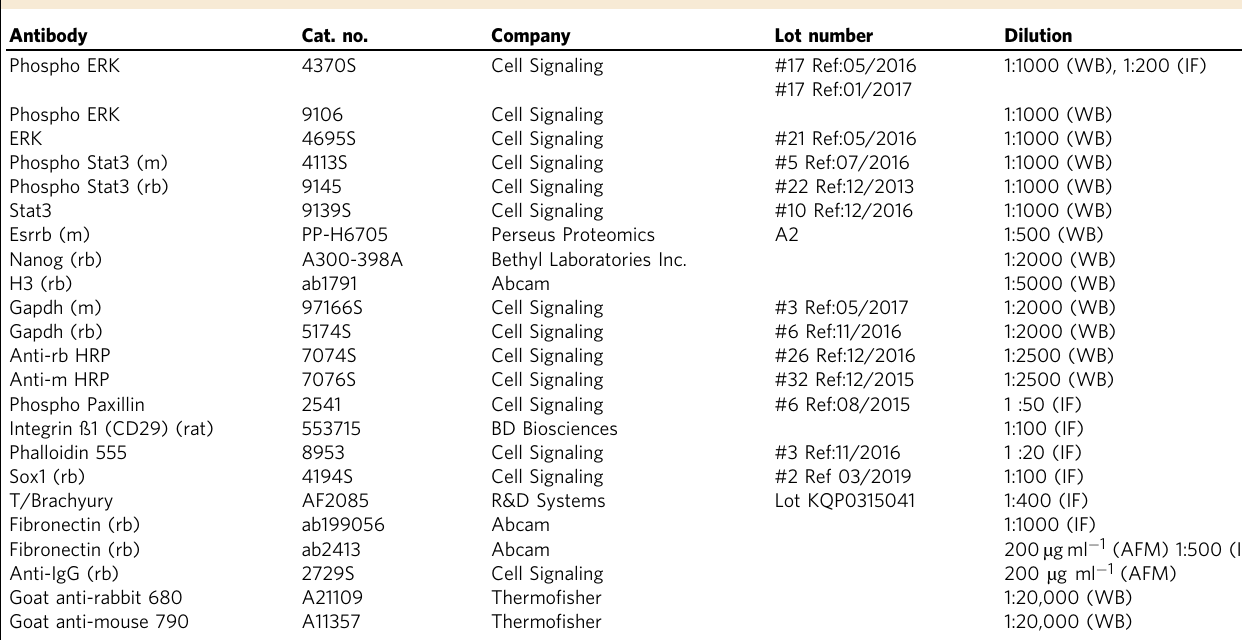
Table 3 List of antibodies. Antibody Cat.